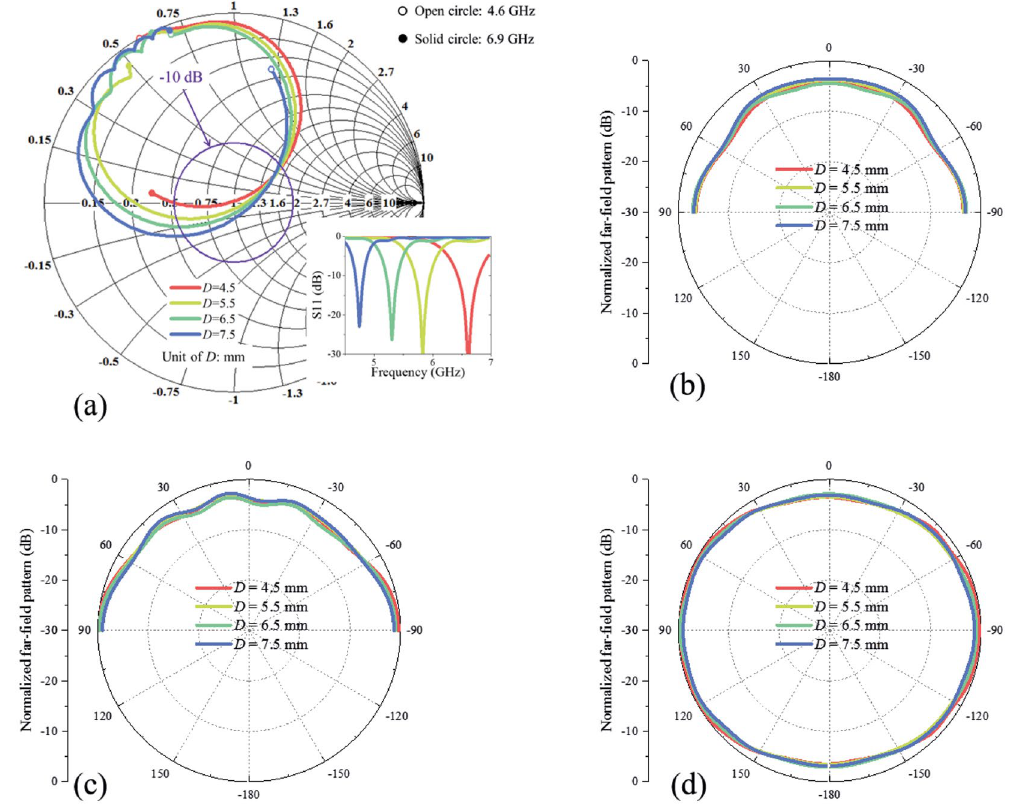
Figure 7. Relations between structure parameter D and antenna performances. ( a ) Impedance matching versus D . The insert figure shows reflection coefficients corresponding to different D . Normalized radiation patterns in xz plane, yz plane, and xy plane at 5.8 GHz versus D are shown in ( b – d ), respectively. Resonant frequency decreases with D and radiation patterns change little with D .